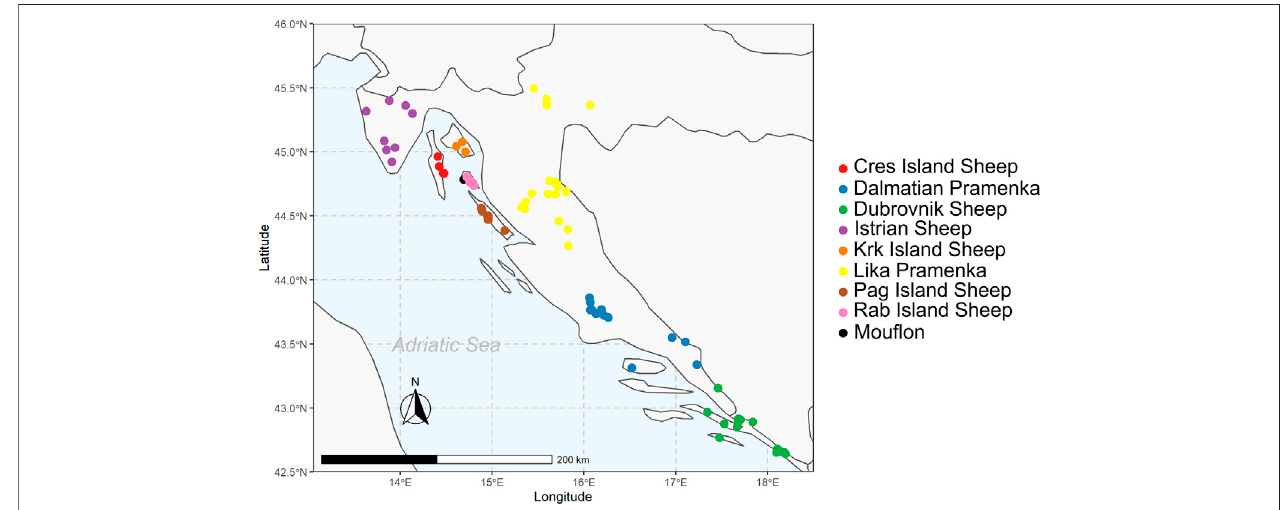
FIGURE1| MapofsamplinglocationsfornativeCroatiansheepbreeds.Themapillustratesthegeographiclocationswheresampleswerecollected.Eachbreedis presented with a different